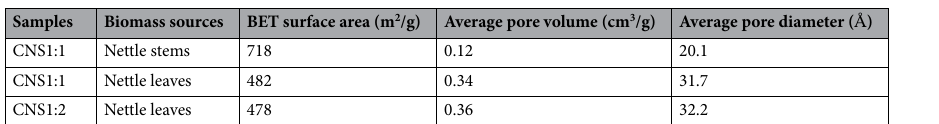
Figure 8. BJH pore size distribution of CNS prepared at 650 °C from nettle ( a ) stems and ( b , c ) leaves using NaHCO 3 as an activating agent. The ratio of nettle powder and NaHCO 3 is 1:1 ( a and b ) and 1:2 ( c ). Insets show the corresponding low pore width zone. ( d ) The corresponding cumulative pore size distribution of nettle leaf- (i and ii) and nettle stem- (iii) derived CNS with the ratio for nettle powder and NaHCO 3 of 1:1 (ii and iii) and 1:2 (i).